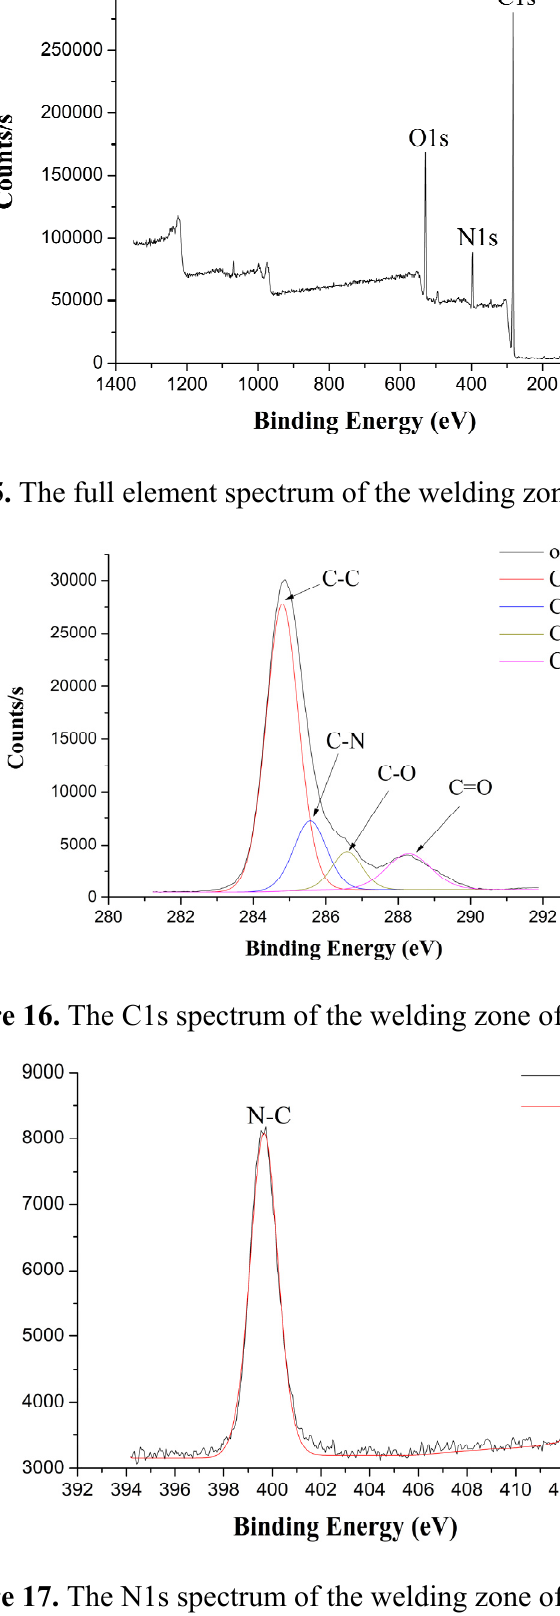
Figure 17. The N1s spectrum of the welding zone of